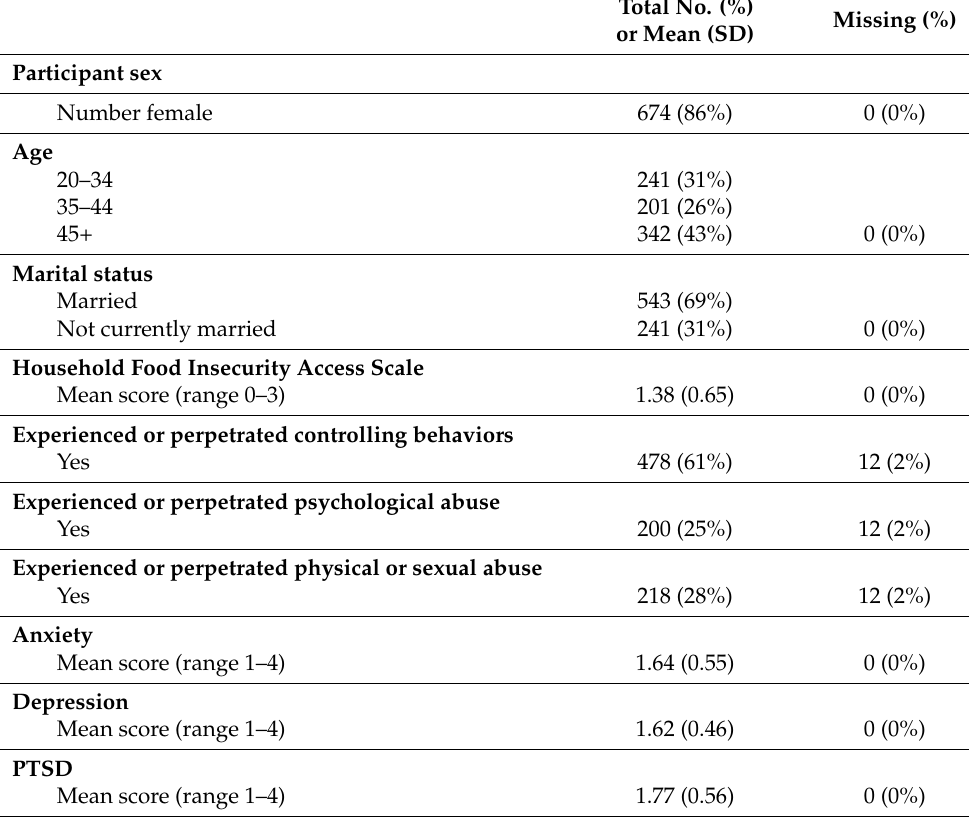
Table 1. Demographic characteristics of sample ( n =